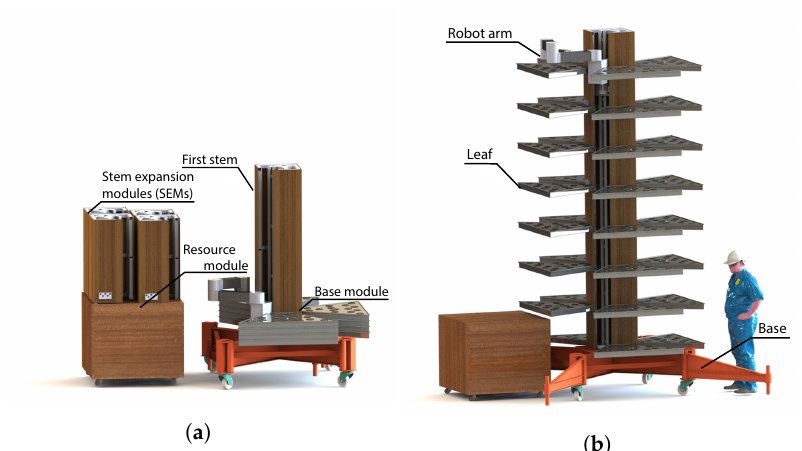
Figure 1. A self-assembling autonomous vertical farm. Figure ( a ) includes a base module (right) and a resource module (left): ( a ) before assembly; ( b ) after